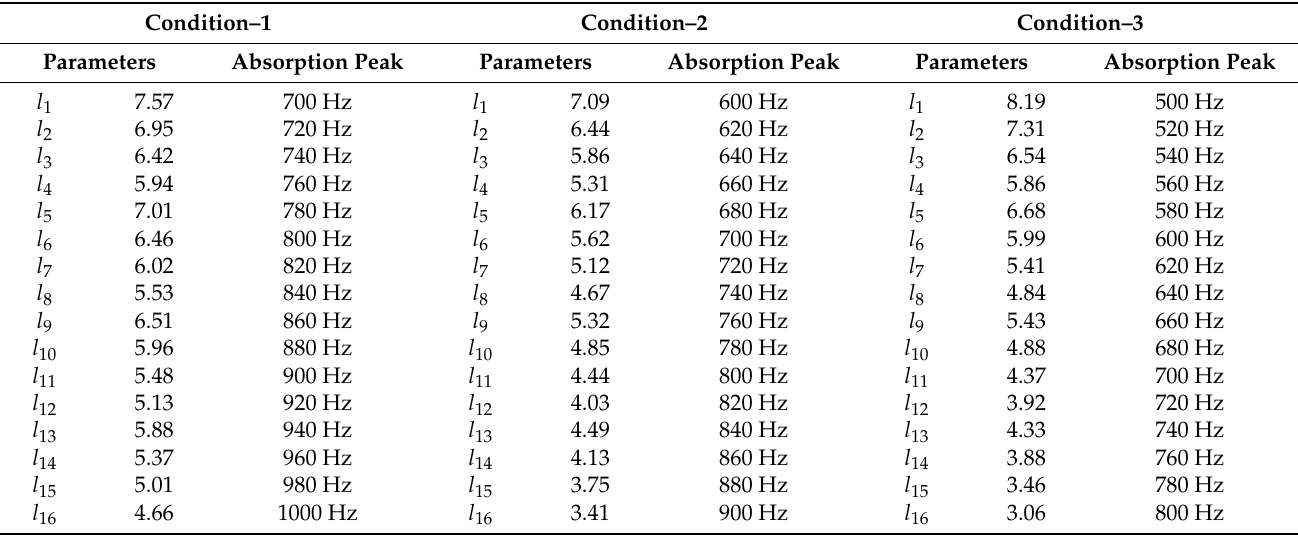
Table 3. Initial values of parameters for the proposed metamaterial